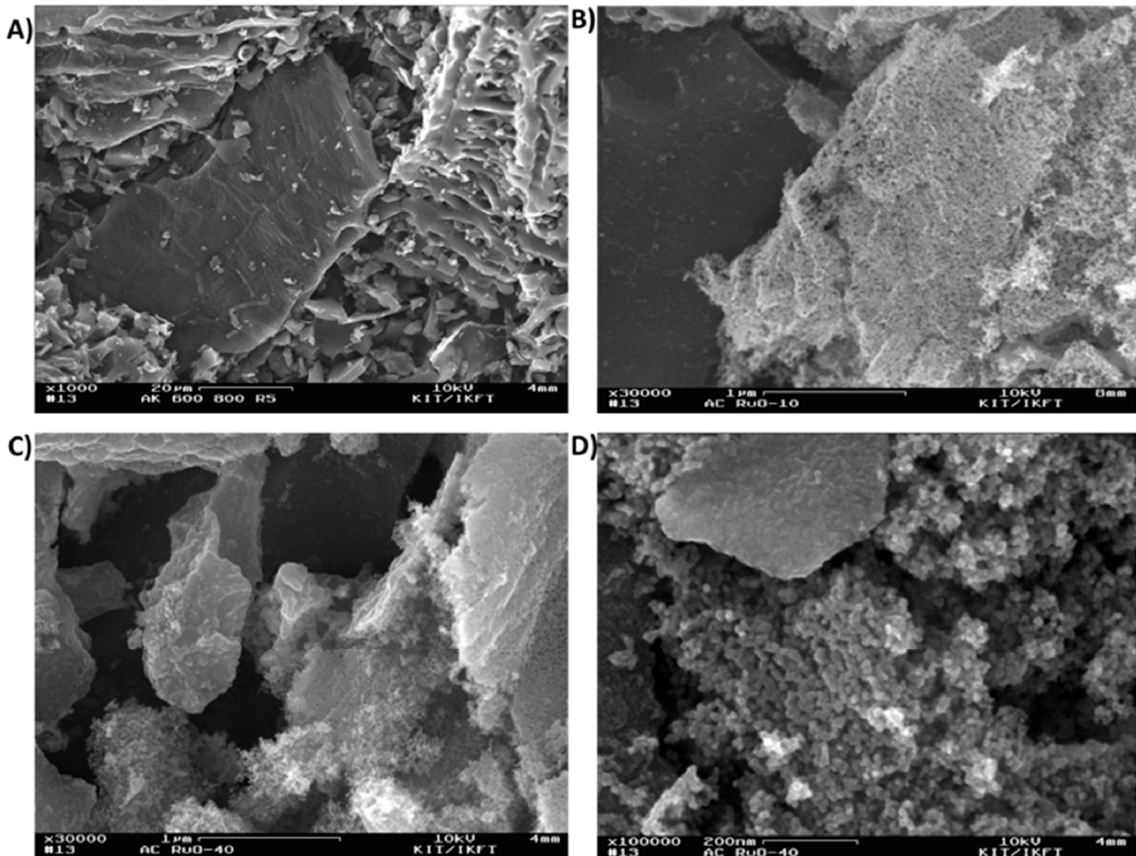
Figure 5. SEM pictures (Inlens SE-detector) of ( A ) AC-600-800, 1000×, ( B ) AC-RuO2-10, 30.000×, ( C ) AC-RuO2-40, 30.000× and ( D ) AC-RuO2-40, 100.000×.